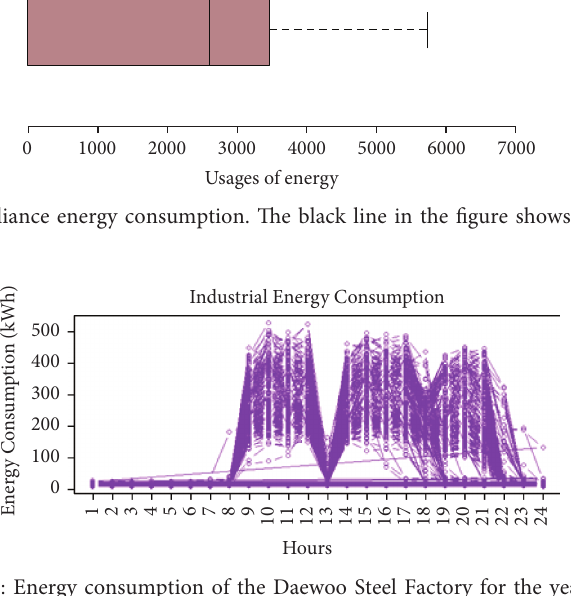
Figure 7: Energy consumption of the Daewoo Steel Factory for the year